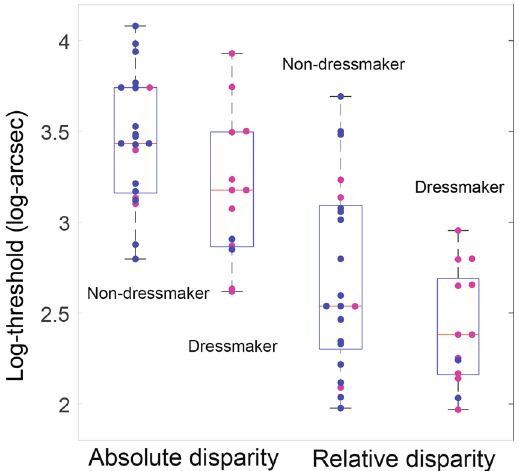
Figure 2. Boxplots of log-transformed thresholds for discrimination of depth from absolute disparities only (left side) and from additional relative disparities (right side), for non-dressmaker and dressmaker groups. The median for each group is in red and the blue box defines the Q1 and Q3 quantiles for each group. The whiskers encompass the entire distribution. Each pink dot is a data point for a female participant and each blue dot is a data point for a male